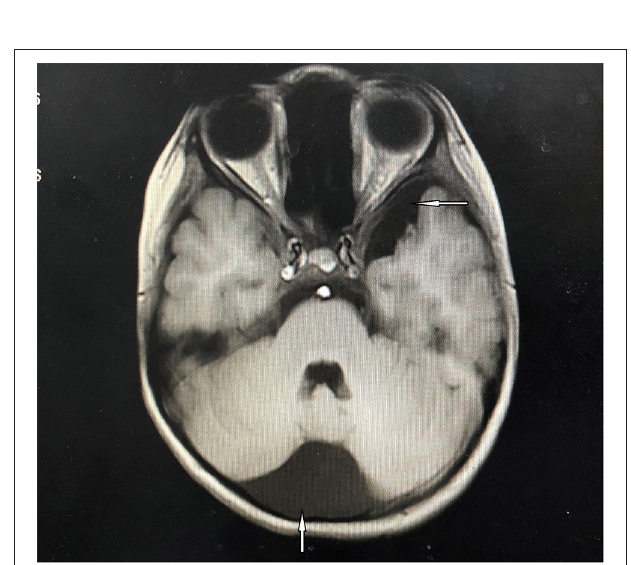
FIGURE 2 | Cranial magnetic resonance imaging. Arachnoid cysts of occipital (the arrow underlying) and left middle cranial fossa (the arrow above) had been